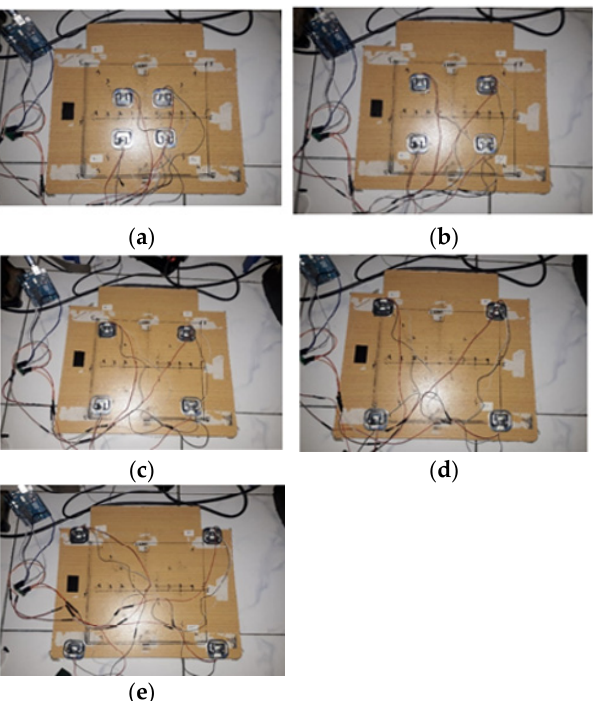
Figure 5. Sensor placement at: ( a ) 3.9 cm distance; ( b ) 7.8 cm distance; ( c ) 11.7 cm distance; ( d ) 15.6 cm distance; and ( e ) 19.5 cm